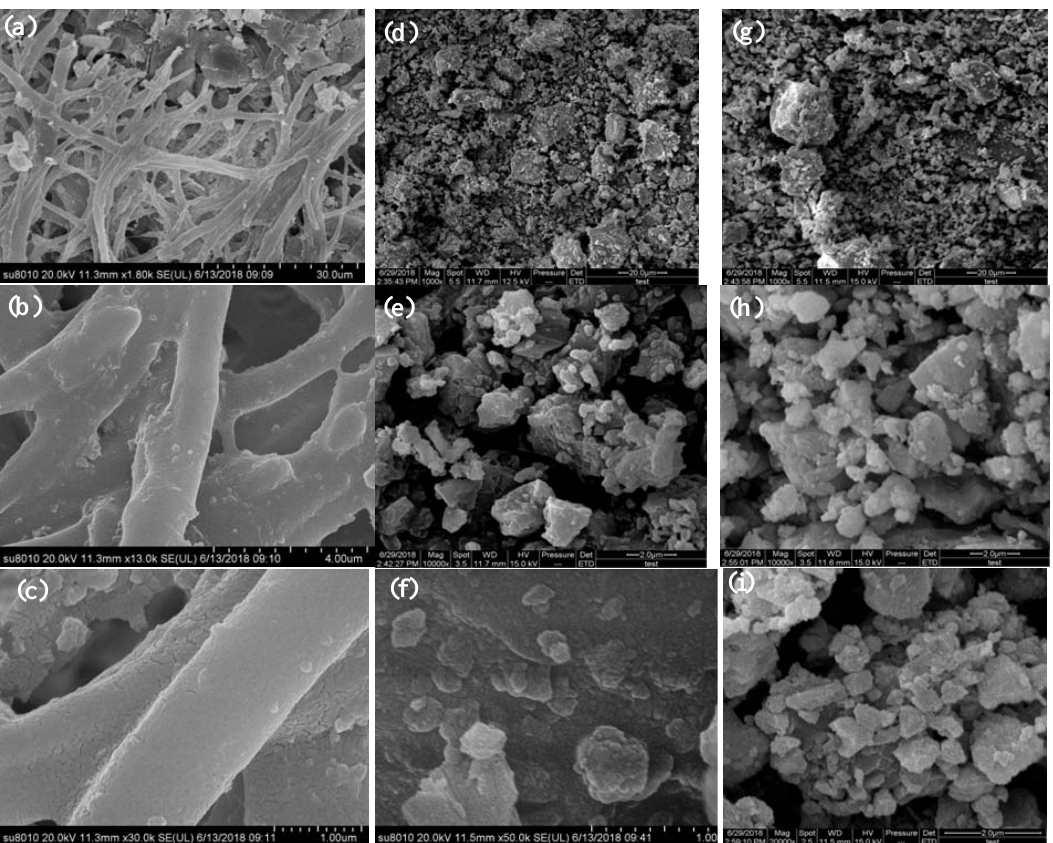
Figure 4. Morphological images of unwashed ( a – c ), untreated ( d – f ), and treated ( g – i ) egg shell particles.